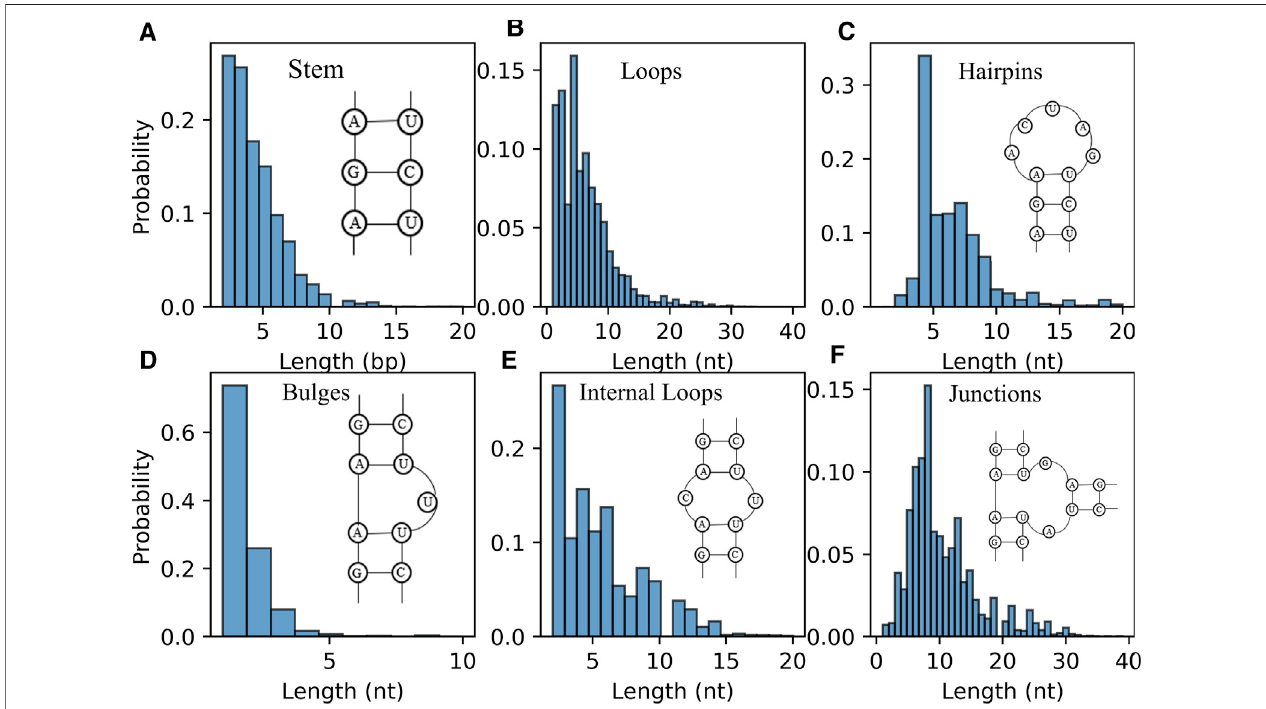
FIGURE6| ThedistributionoflengthofRNAsecondarystructuremotifsinthedataset. (A) Histogramoftheoccurrenceforthelengthofstems. (B – F) Histogramof the occurrence for the length of loops (B) all loops; (C) hairpin loops; (D) bulge loops; (E) internal loops; (F) junction loops.